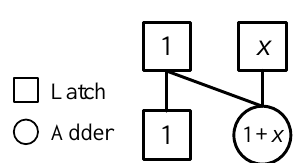
Figure 1. The 1-network.